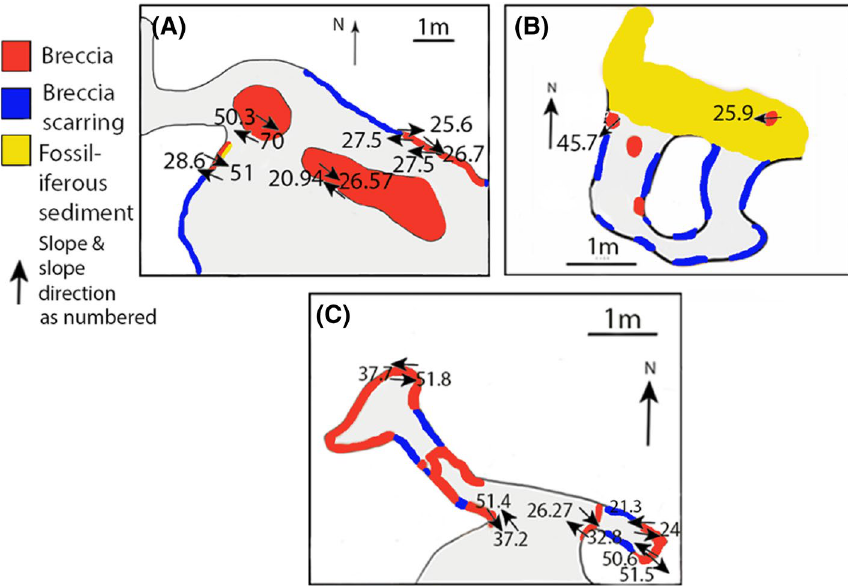
Figure 8. ( A – C ) The average slope and slope direction of the internal clasts of the breccia subsamples in relation to the cave passage orientations, mapped directly onto the colour scale cave profile section from ( A